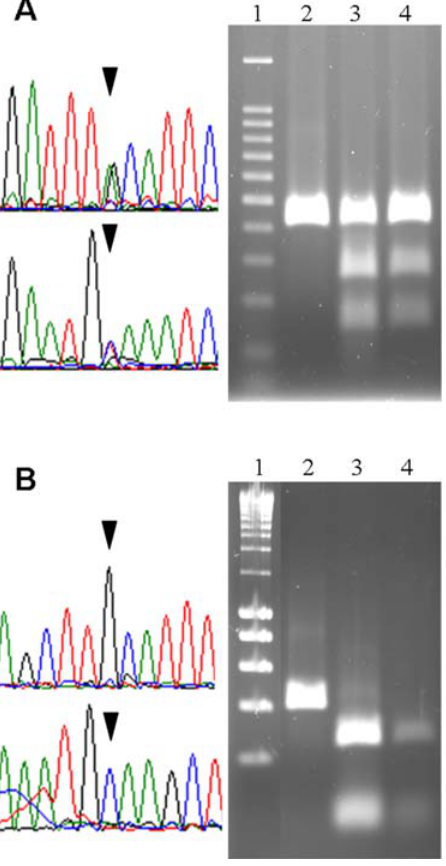
Figure 1. Assessment of character state at nucleotide position 11973 relative to the Armadillidium vulgare mitochondrial genome sequence. (A) Presence of the 11973G/A heteroplasmy in mitochondrial DNA extracts of A. vulgare individuals. Direct sequencing of a heteroplasmic female sample (left) with forward (top) and reverse (bottom) primers. Partial trace files are shown, with the 11973G/A heteroplasmy highlighted with black triangles. HpyCH4V digestion profiles (right). Lanes: (1) 100 bp molecular ladder (BenchTop, Promega), (2) undigested control amplicon, (3) and (4) digested amplicons of two heteroplasmic female samples. (B) Presence of the 11973G homoplasmic state in Chaetophiloscia elongata individuals. Direct sequencing of a homoplasmic individual (left) with forward (top) and reverse (bottom) primers. Partial trace files are shown, with the 11973G homoplasmy highlighted with black triangles. HpyCH4V digestion profiles showing complete digestion of the PCR products (right). Lanes: (1) 200 bp molecular ladder (SmartLadder, Eurogentec), (2) undigested control amplicon, (3) and (4) digested amplicons of two homoplasmic samples.